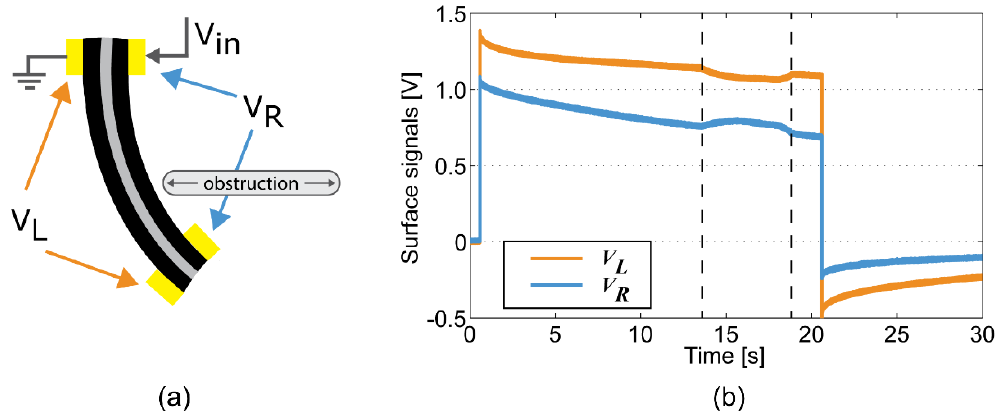
Figure 11. ( a ) Measurement setup for acquiring voltage drops during the work-cycle of a carbide-derived-carbon-based actuator; ( b ) voltage drops along the electrodes of this actuator, free movement of the actuator was obstructed at the 14th second of the experiment. Figure is adapted from